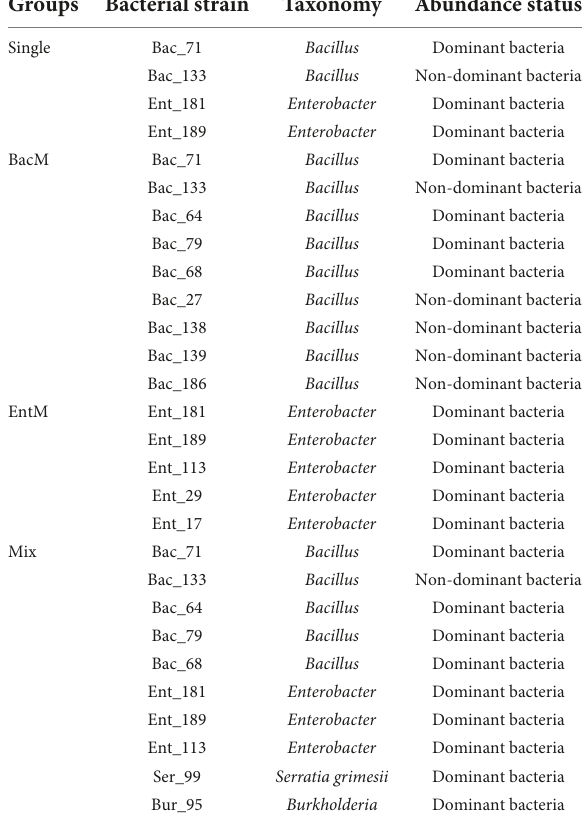
TABLE 2 Bacterial strains of the inoculated bacterial complex in the wheat